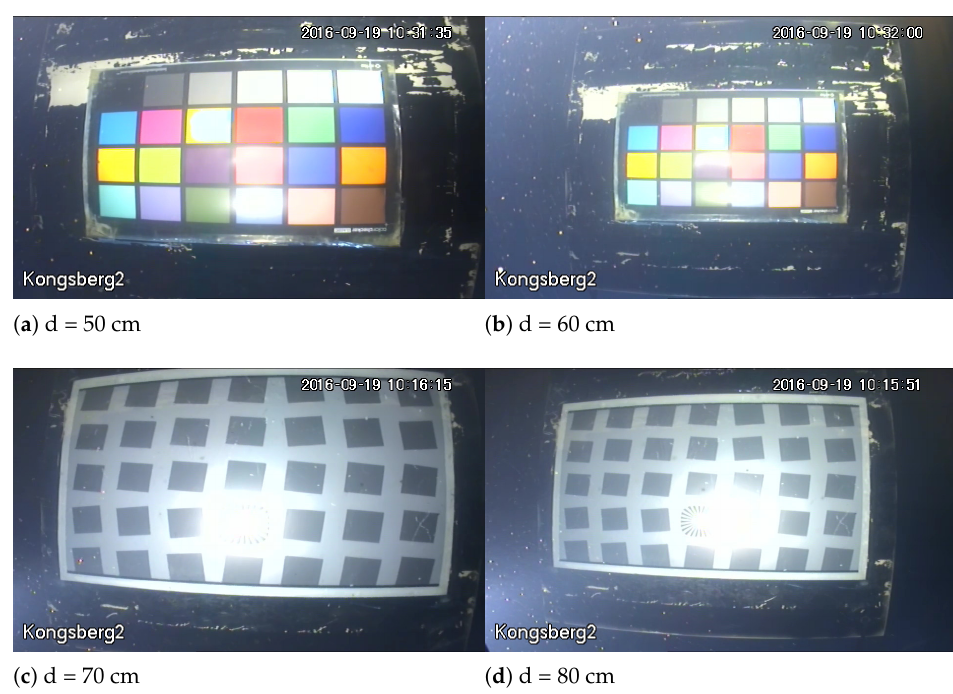
Figure 3. The transparency of water body is 325 cm, and some images under artificial light source.